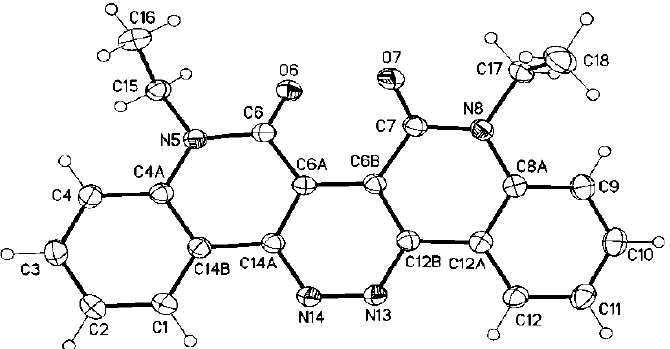
Figure 2. Molecular structure of one of the crystallographic independent molecules of 3a.